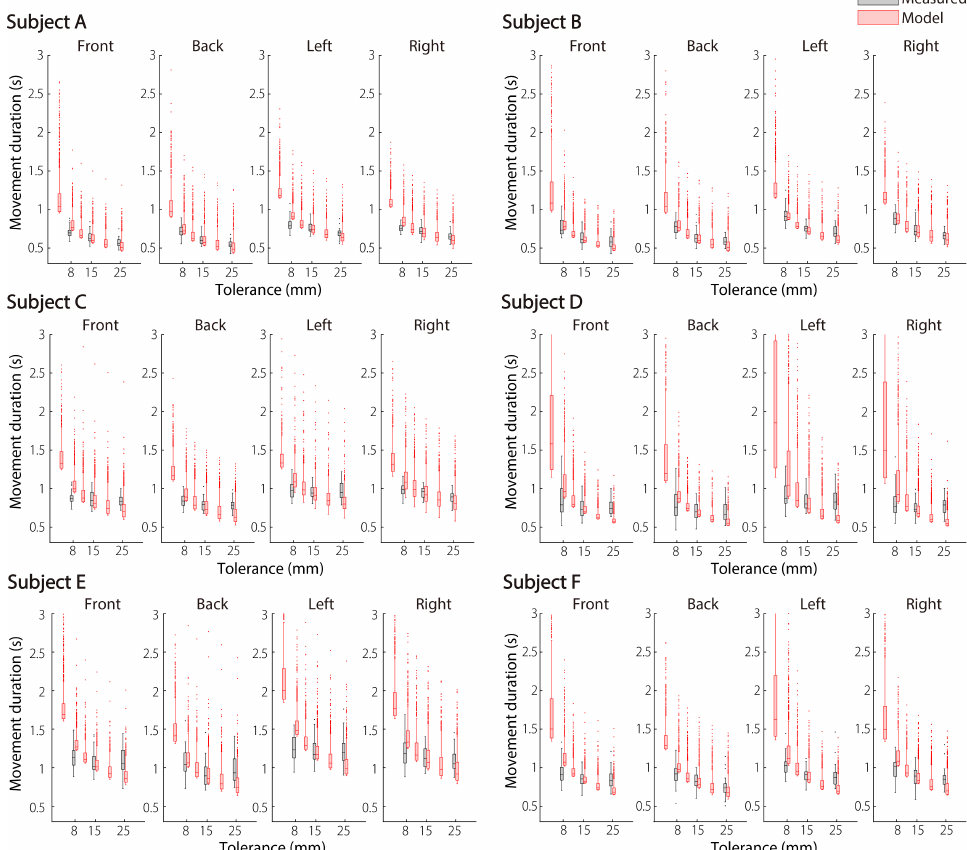
Figure 4. Comparison of the measured and model movement durations for all subjects. When the λ determined for each direction was used. The horizontal axis represents tolerance, and the vertical axis represents movement duration. The black box plot denotes the measured movement duration at a given tolerance: 8.00, 15.0, and 25.0 mm. The red box plot represents the model movement duration generated for 1000 trials when tolerances of 4.00, 8.00, 11.5, 15.0, 20.0, and 25.0 mm were given. The light red dots indicate outliers (greater than third quartile + 1.5 ×